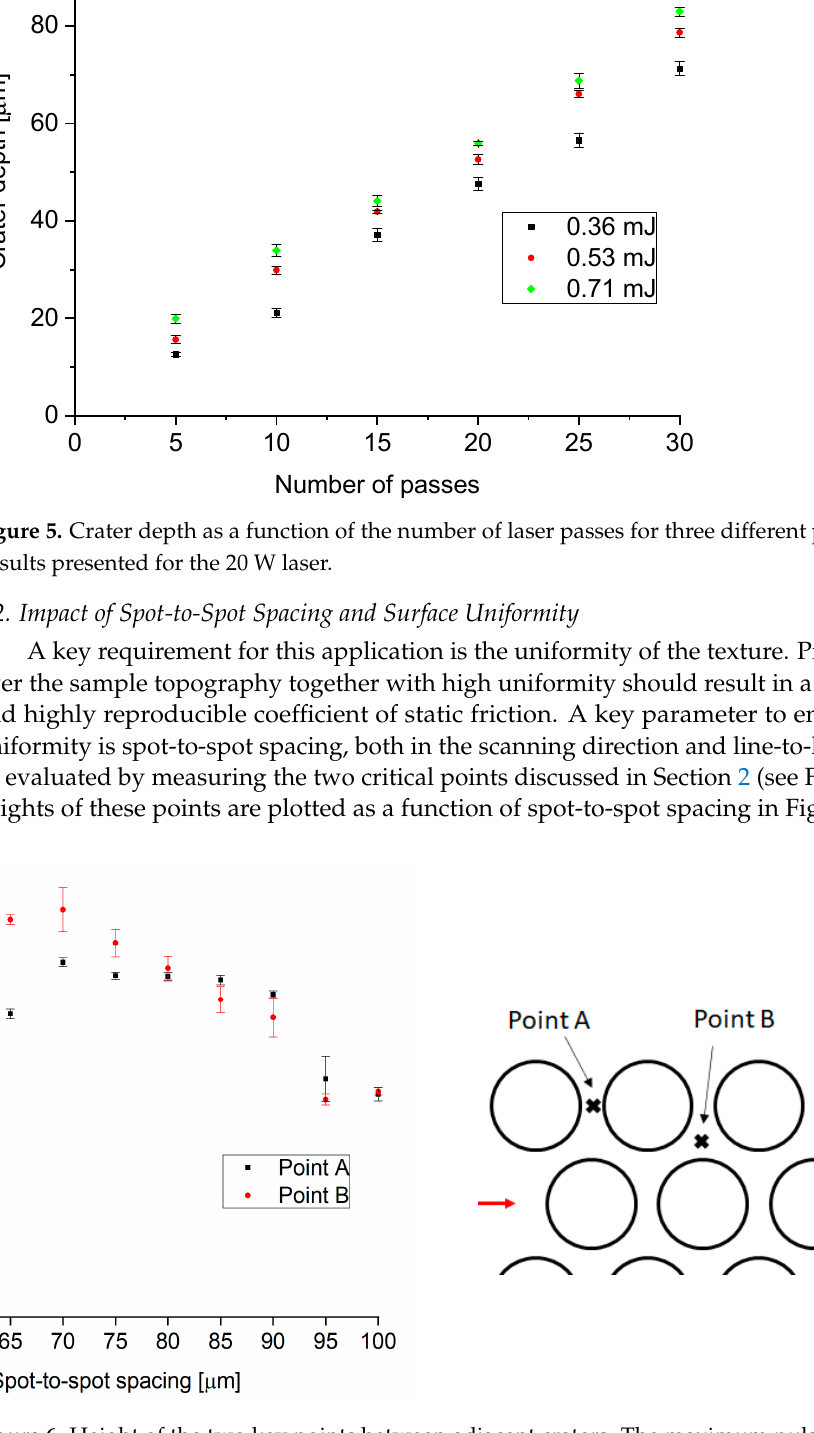
Figure 6. Height of the two key points between adjacent craters. The maximum pulse energy used was 0.71 mJ.